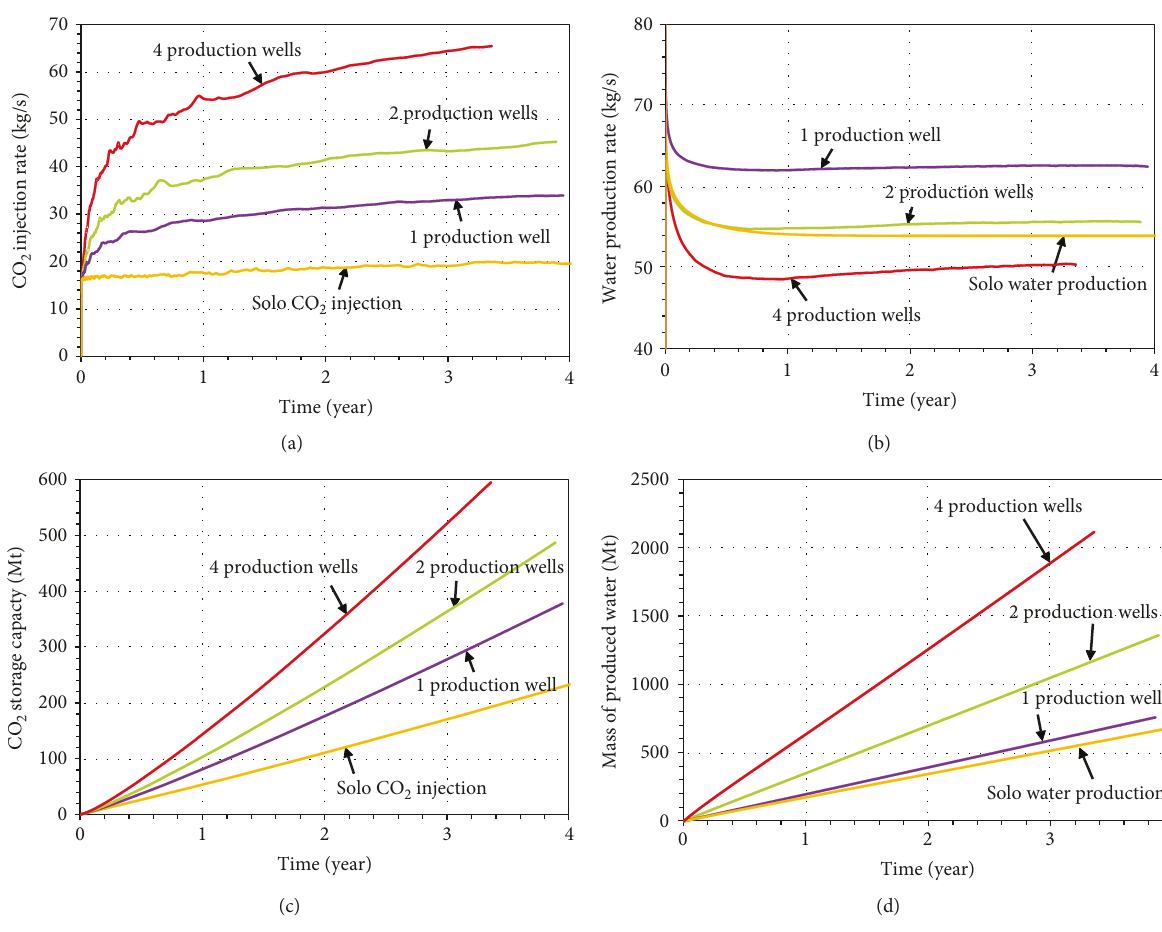
Figure 9: The e ff ect of the number of production wells on the CO production rates. (c, d) Injection and production amounts.